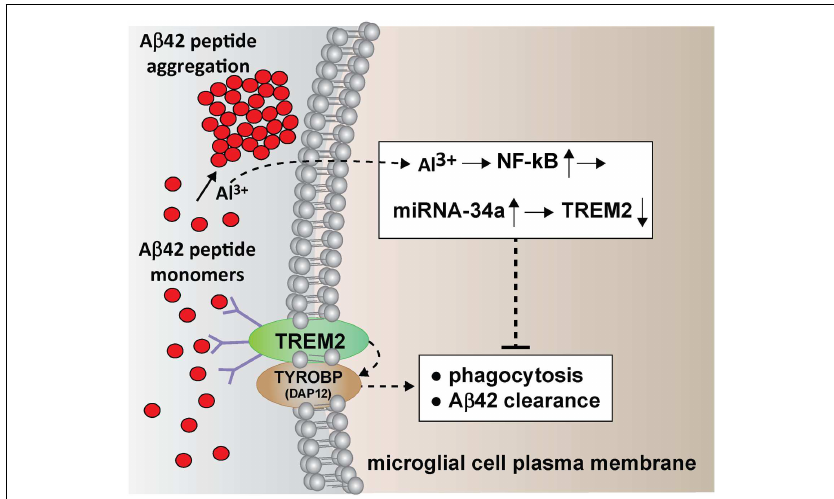
FIGURE 1 | Multiple neurotoxic actions of aluminum results in an impairment in the clearance of A β 42 peptides that drives amyloidogenesis andAD-type change ; in intra-cellular and intra-nuclear compartments, aluminum induces NF-kB (5, 14, 15), up-regulates miRNA-34a (9, 10), and down-regulatesTREM2, a key microglial intra-membrane phagocytic sensor protein (6–8, 11); lack of sufficientTREM2 impairs microglial cell-mediated phagocytosis and clearance of A β 42 peptide monomers; deficits inTREM2 (but not theTREM2-associatedTYROBP/DAP12 adaptor protein required for phagocytosis and A β 42 peptide engulfment) have been widely reported in AD brain and in stressed microglial cells (7, 8, 11); in the extracellular space (upper left) aluminum aggregates A β 42 peptide monomers into dense insoluble spherical clumps and promotes senile plaque formation; the movement of Al3 + across the plasma membrane is not well understood but may involve both active and passive transport; while microglia are able to phagocytose A β 42 peptide monomers that they may have difficulty with higher order aggregates resulting in microglial activation and a pathogenic pro-inflammatory response that contributes to AD